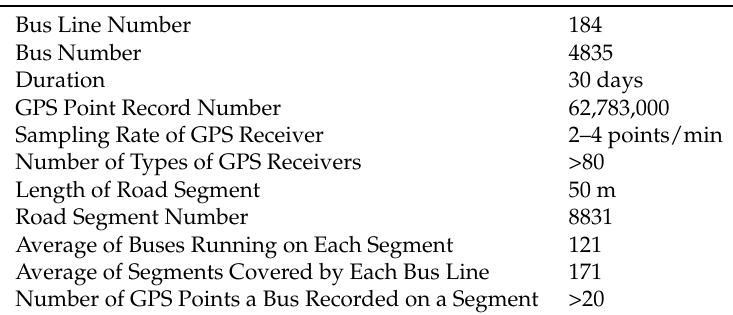
Table 1. Dataset description.